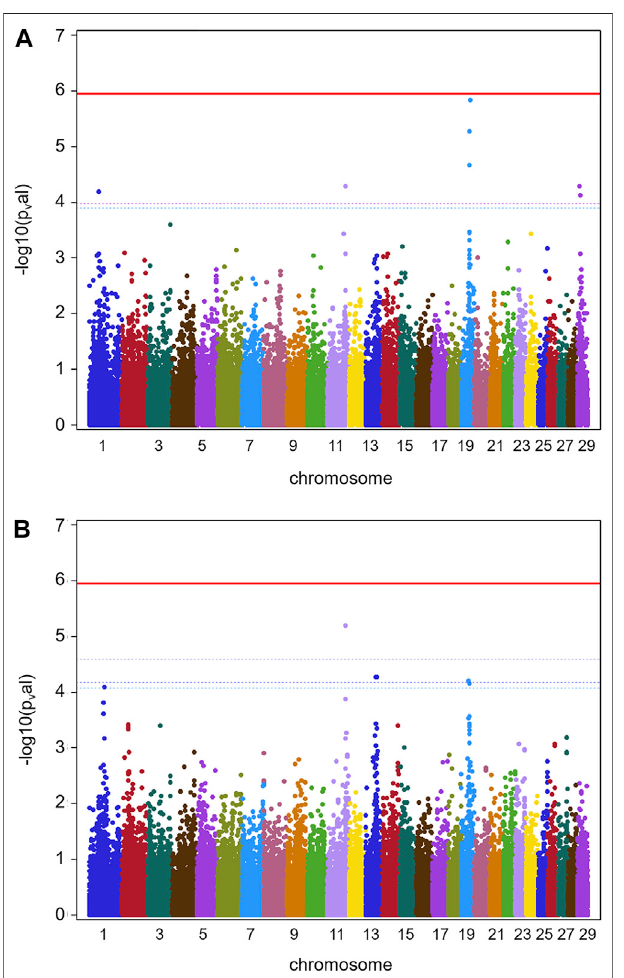
FIGURE 1 | GWAS results for data batch 1 (herds 1 – 7). (A) Manhattan plot derived from the results of GWAS analysis (Ensembl genome assembly UMD3.1) for trait TBIN. (B) Manhattan plot obtained from theresults ofGWAS analysis for trait TCHRONA. In all plots -log10 p -values of detected SNP sorted by chromosomes are shown. Red line indicates genome-wide (5%) false discovery rate (FDR). Colored dotted lines indicate chromosome-wise (5%) FDR with line and corresponding chromosome of the same color.